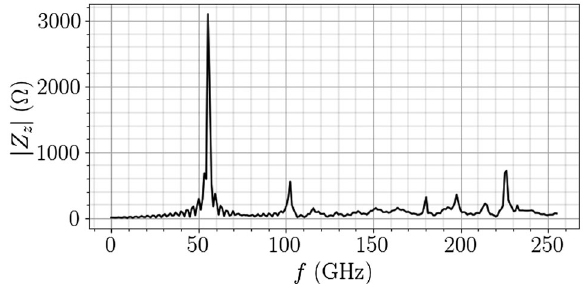
FIG. 12. The z component of the transition section wakefield impedance showing interaction with the trapped mode at 55 GHz.